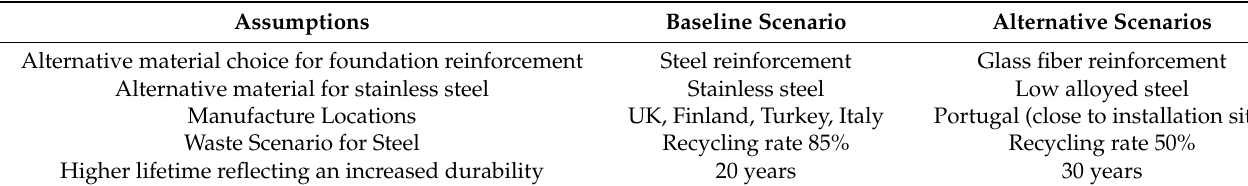
Table 6. Parameters for scenario analysis.